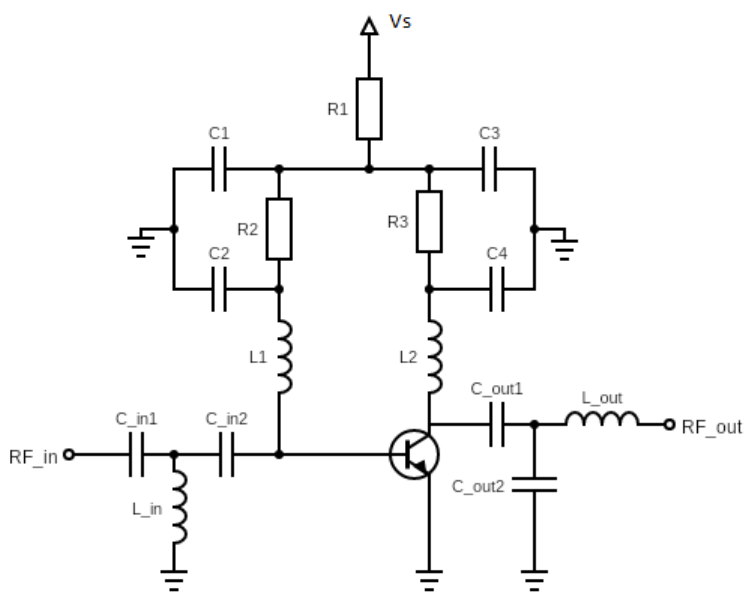
Figure 4. Common emitter LNA architecture based BFP740